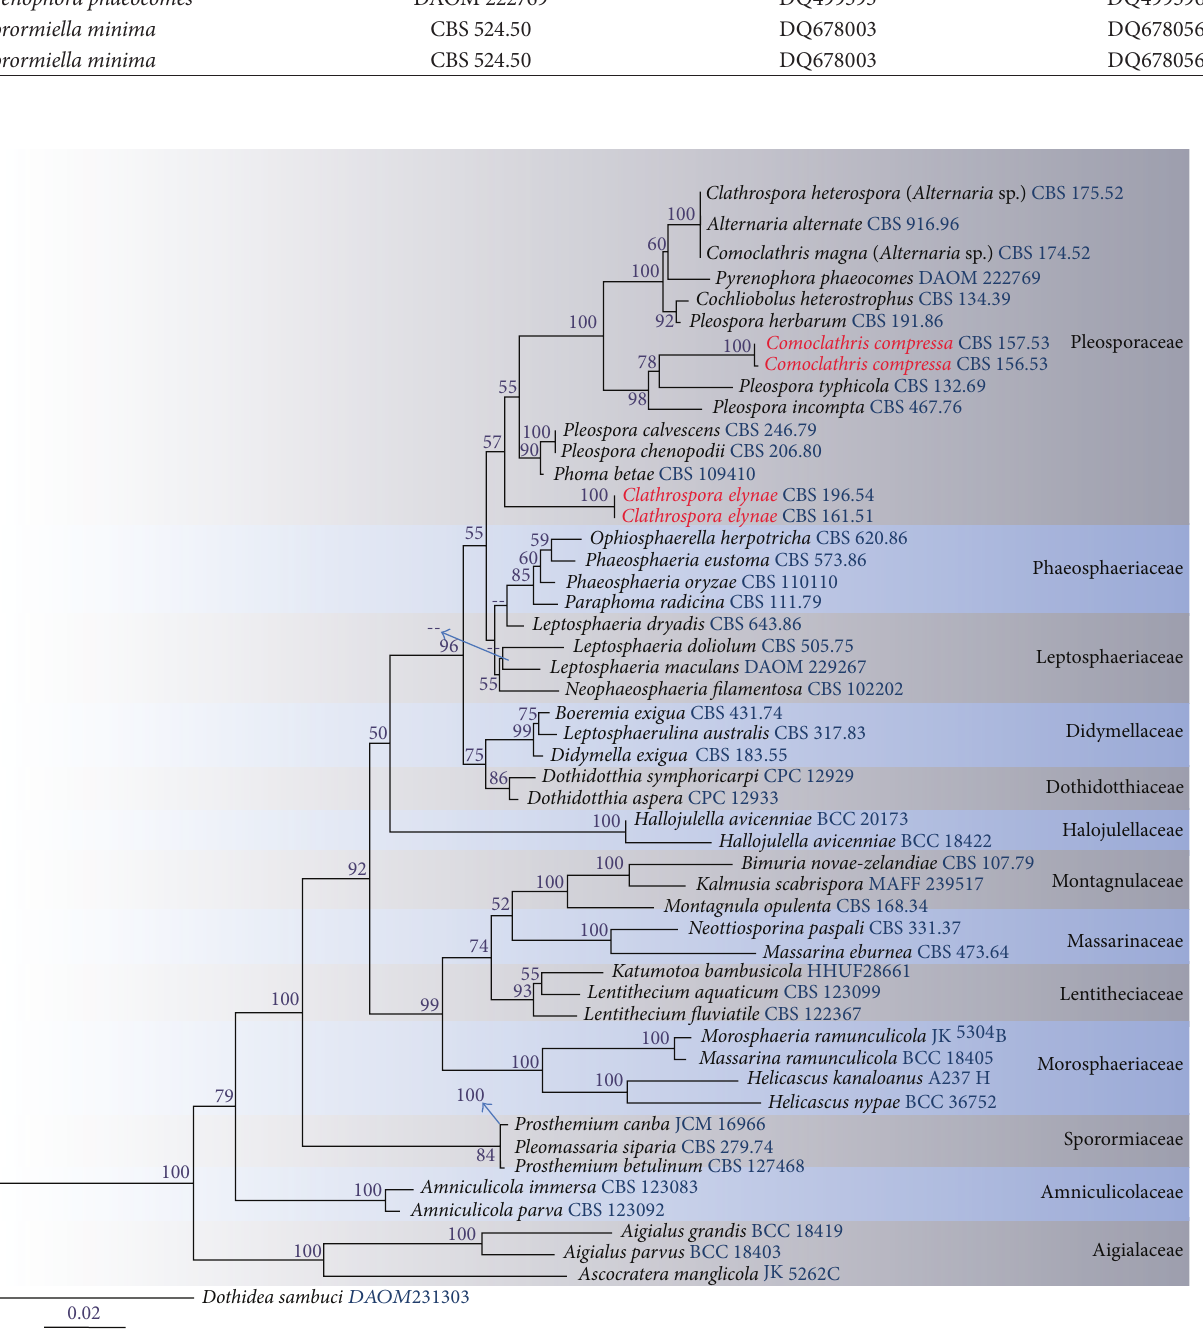
Figure 1: RAxML tree based on a combined dataset of SSU and LSU. Bootstrap support values > 50% are shown above or below the branch. The putative strains of Clathrospora elynae (CBS 196.54 and CBS 161.51) and Comoclathris compressa (CBS 157.53 and CBS 156.53) are indicated in red. Dothidea sambuci is the out-group taxon. The original isolate numbers are noted after the species